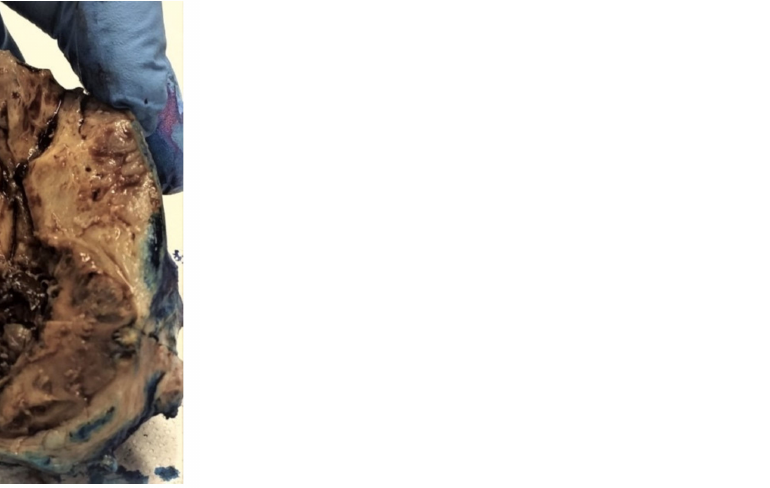
Figure 13. Encapsulated ovarian tumor diagnosed as embryonal carcinoma (courtesy of Dr. M.